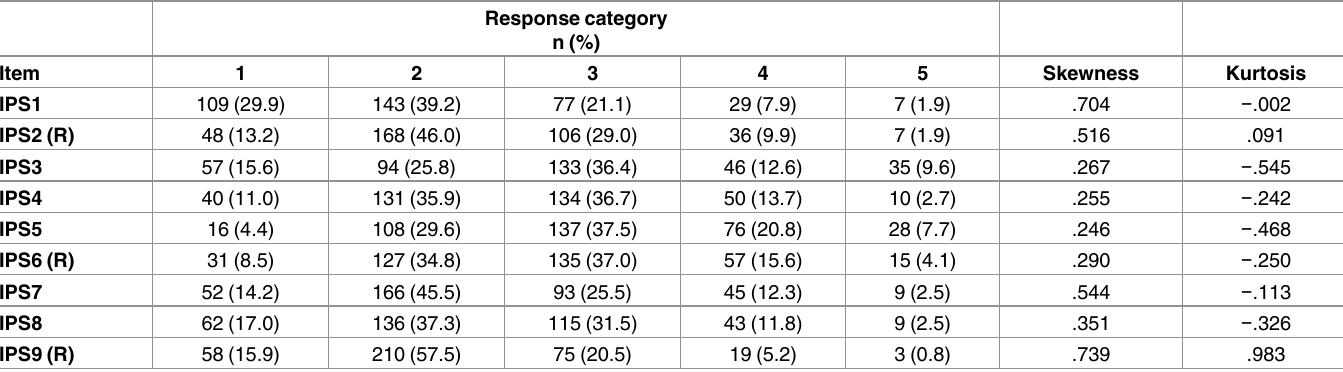
Table 2. Item endorsements in each response category and corresponding skewnessand kurtosis